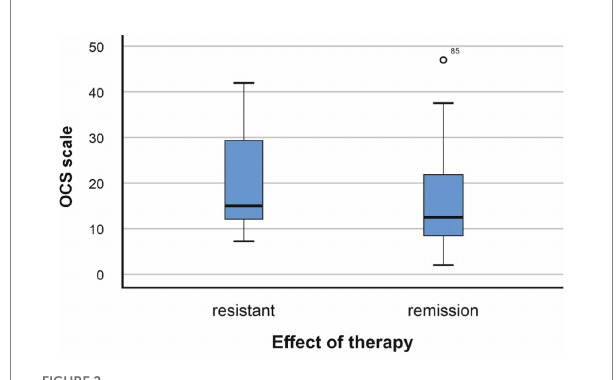
FIGURE 2 Relationship between resistance to therapy and obsessive– compulsive symptoms ( p = 0.015, F = 0.648; Mann–Whitney U test − 966,500, p = 0.013).